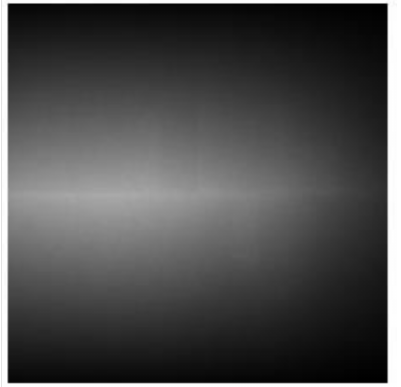
Figure 11. The diffraction images of subgrid C in Figure